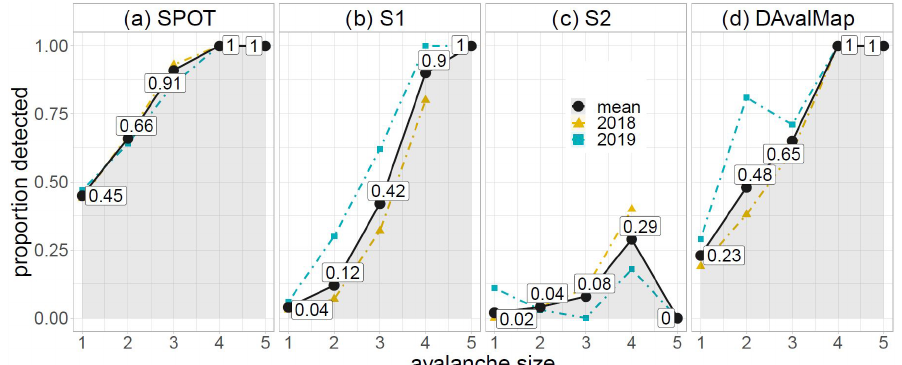
Figure 8. (a–d) POD by size for each of the avalanche mapping methods tested. The black dots and line represent the mean proportion of avalanches per size identified by the different mapping methods; additionally the proportions are shaded grey. In addition, the values for 2018 (yellow triangles) and 2019 (turquoise squares) are shown for each mapping method. For the number of avalanches in each size class and subset, refer to Fig.